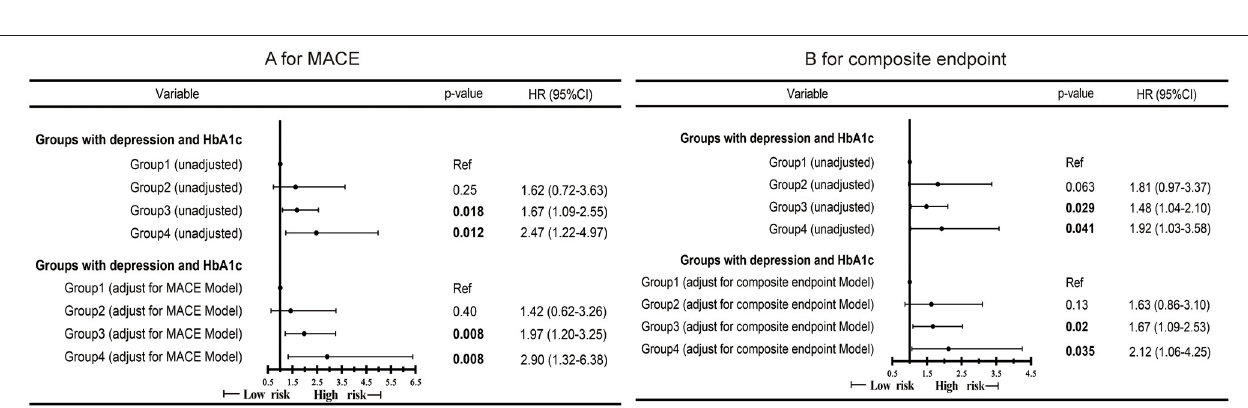
FIGURE 1 | Cox regression curves for MACE (A) and composite endpoint (B) by the four groups of all patients. (Group1: patients without clinical depression and low HbA1c; Group2: patients with clinical depression and low HbA1c; Group3: patients without clinical depression and high HbA1c; Group4: patients with clinical depression and high HbA1c).